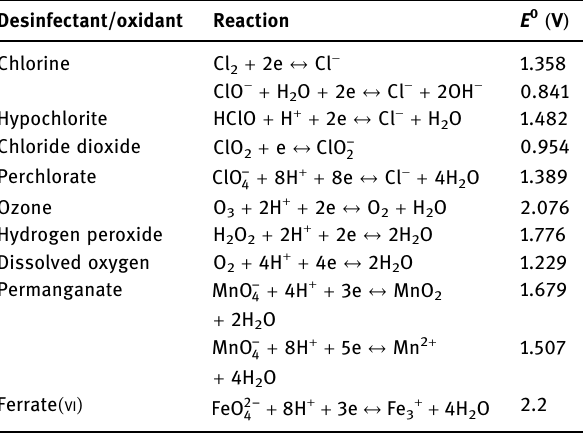
Table 1: Redox potential for the oxidants/disinfectants used in water and wastewater treatment [ 11 ]